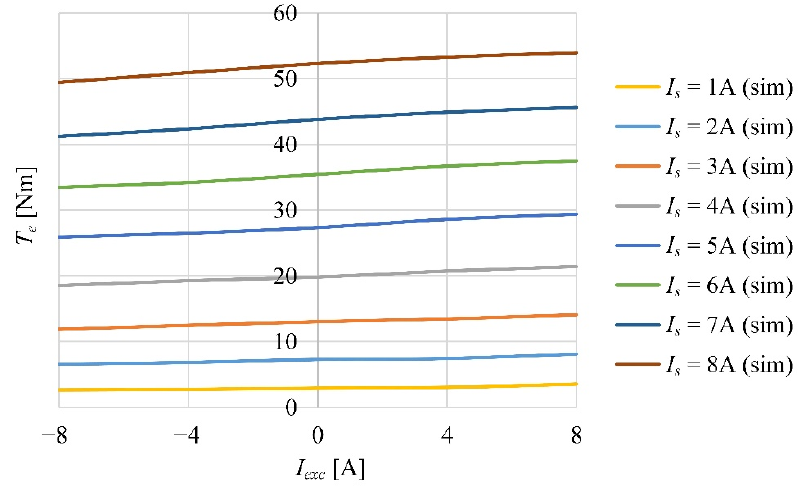
Figure 8. RMS value of back-EMF vs. rotational speed for different values of DC coil current.